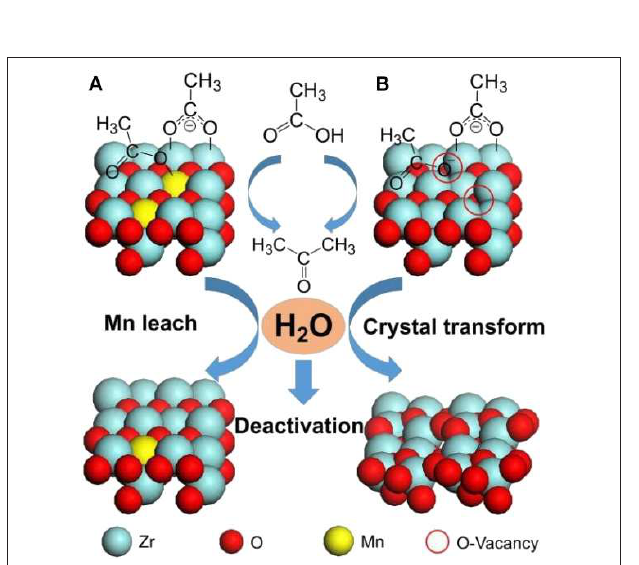
FIGURE 11 | Aqueous-phase ketonization and deactivation process on tetragonal (011) facet of (A) ZrMn y O x (y ≥ 0.2) and (B) ZrMn 0 O x catalysts. Reprinted from Wu et al. (2017a), with permission from Wiley.